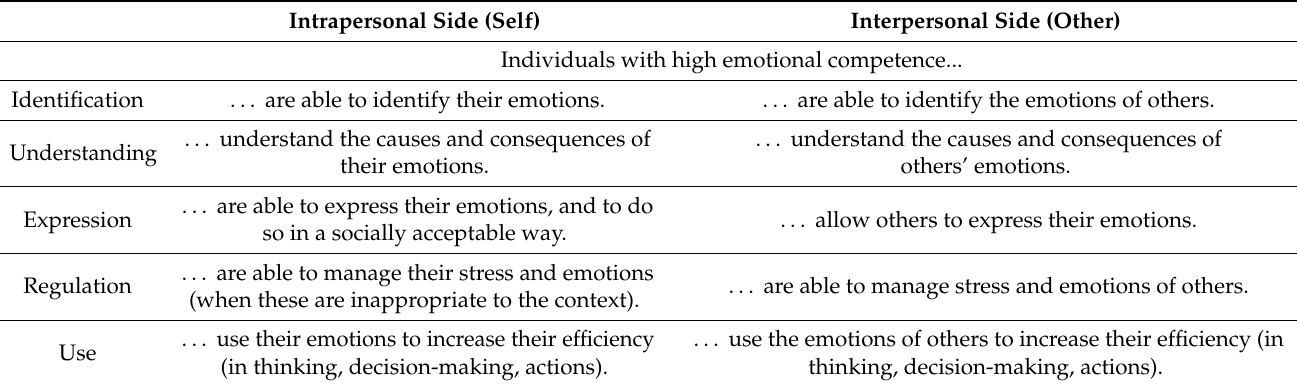
Table 1. Five basic emotional competencies in their interpersonal and intrapersonal aspects (adapted and translated with permission from Mikolajczak, M.; Quoidbach, J.; Kotsou, I.; Nelis, D. Les comp é tences é motionnelles, New presentation © 2020, Dunod Editeur, Malakoff). Intrapersonal Side (Self) Interpersonal Side (Other) Individuals with high emotional